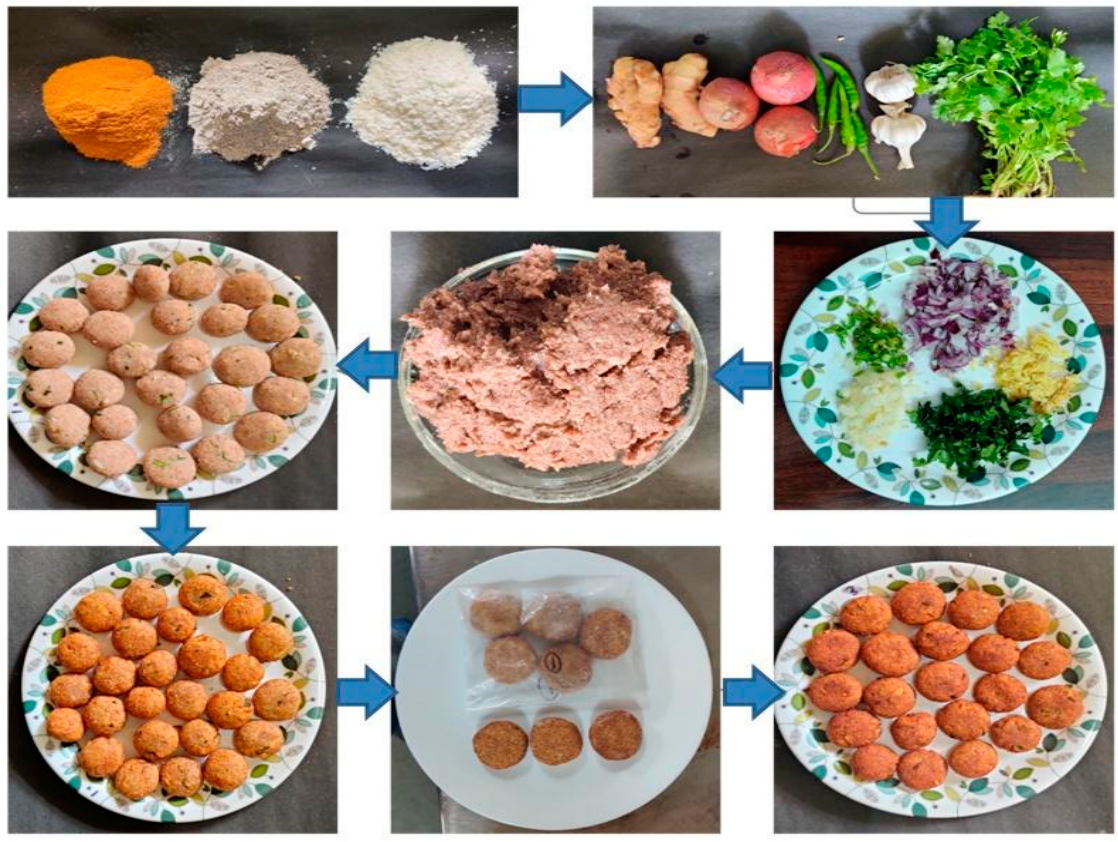
Figure 1. Process for Preparation of RTC-GF Snack.